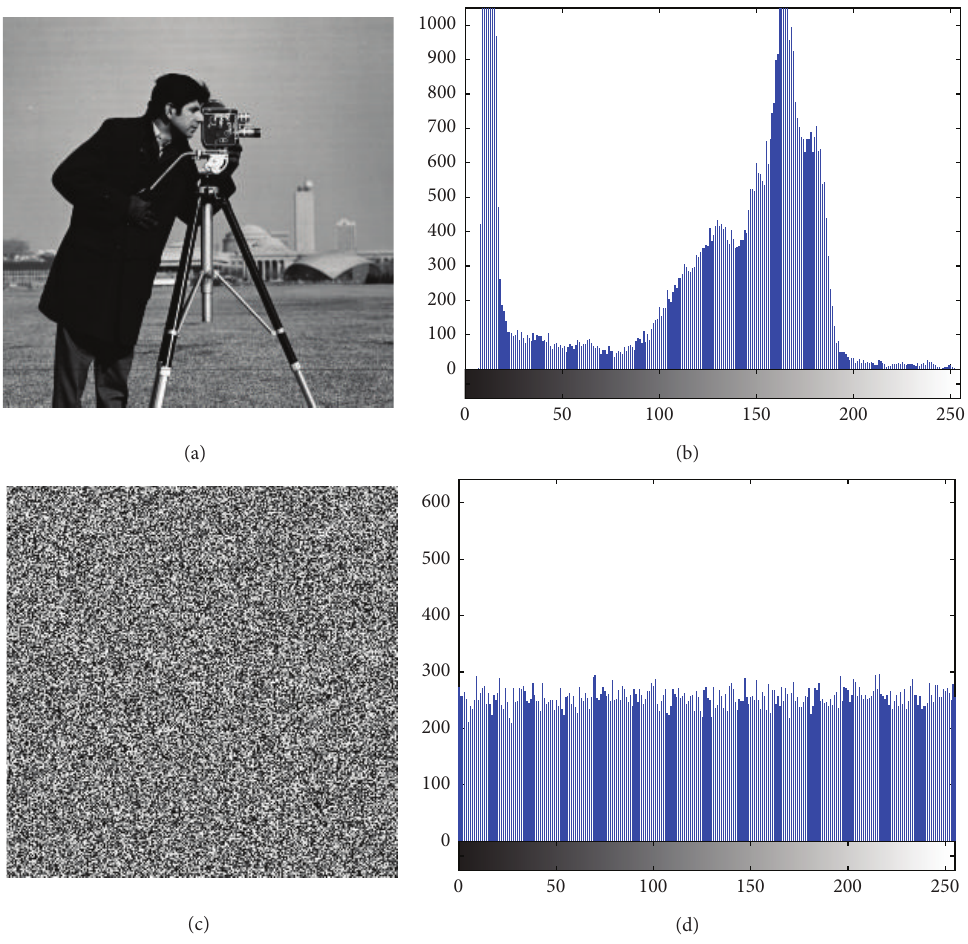
Figure 14: (a) Cameraman image and (b) its histograms and (c) encrypted image and (d) its histogram. Table 7: Difference rate of two decrypted images with slight change in a